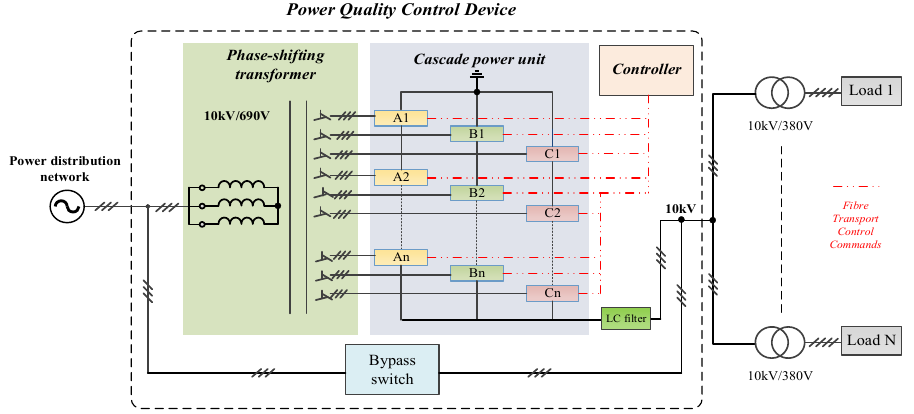
Figure 1. Main loop diagram of the cascaded power quality improvement device.